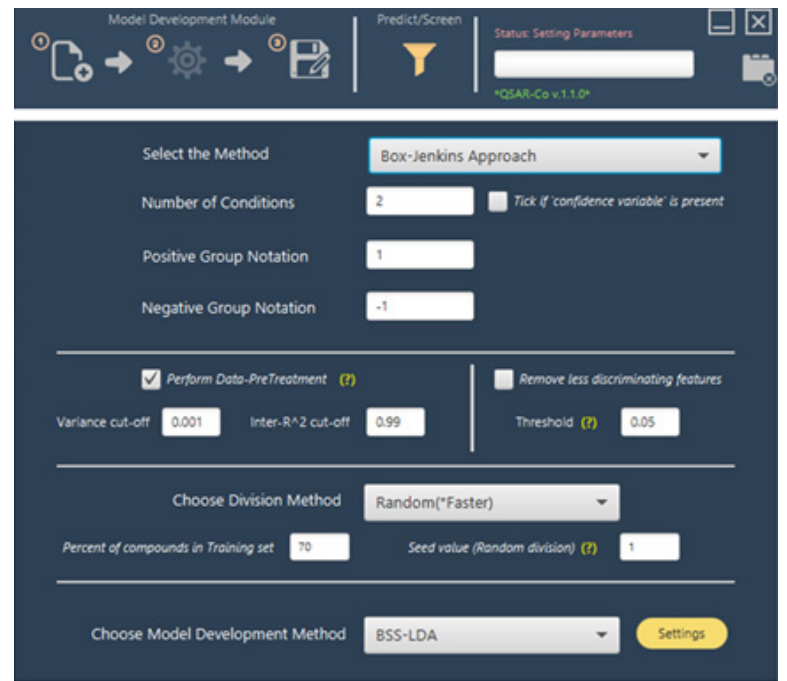
Figure 4. Screenshot of the latest version of QSAR-Co (version 1.1.0)